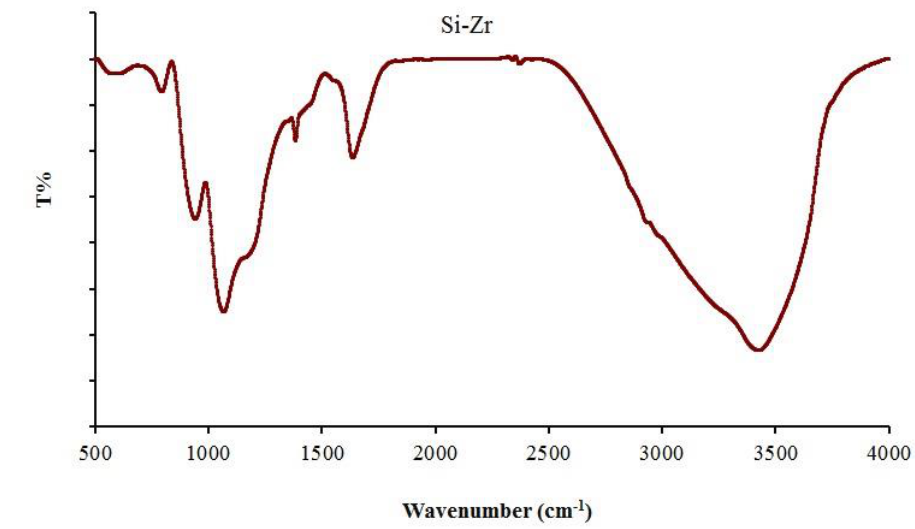
Figure 1. FTIR spectra Si/Zr nanocomposite coating that heat treated at 450 ◦